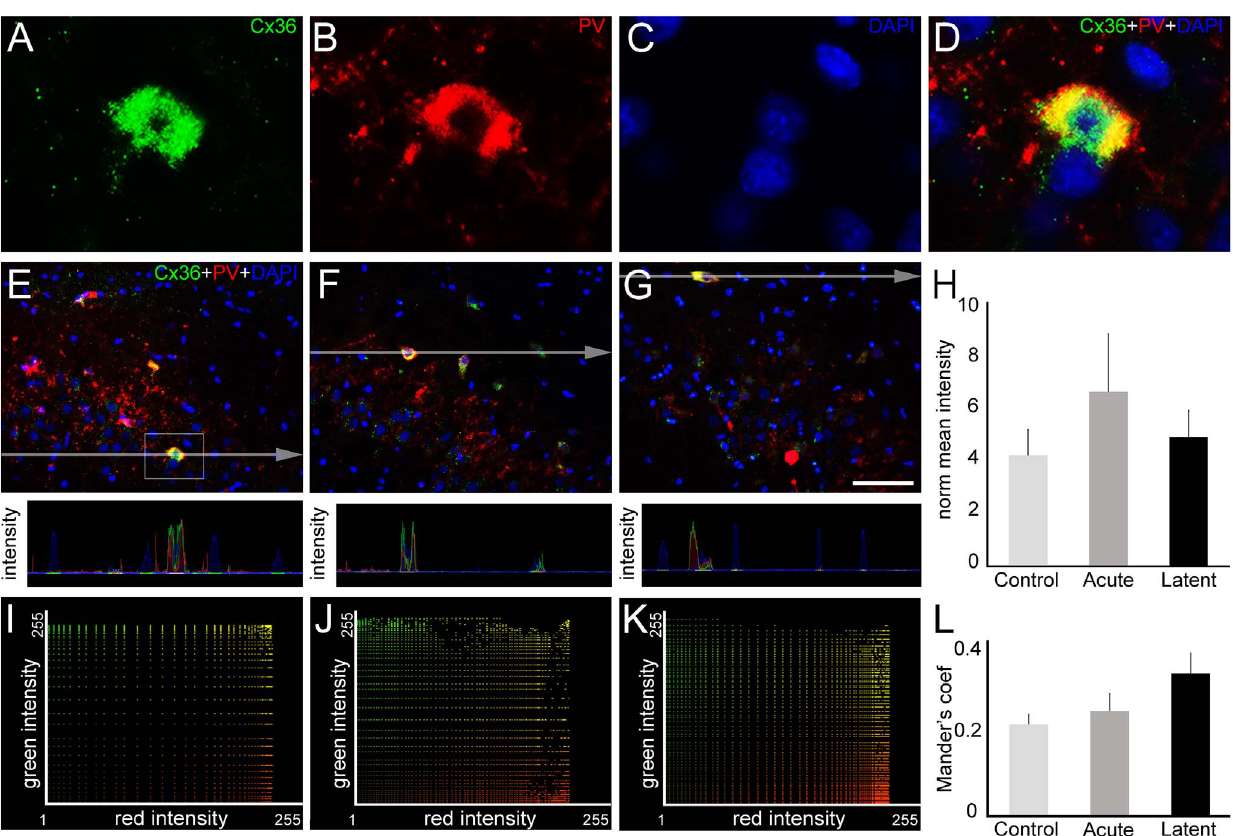
Figure 5. Cx36 expression in parvalbumin (PV)-positive interneurons into CA3. In order to quantify the amount of Cx36 (green) in PV- positive cells (red), we performed double-labeling experiments in coronal sections of rats from control, acute and latent groups counterstained with 4 9 ,6-diamidino-2-phenylindole (DAPI, blue). (A–D) High magnification of the selected area highlighted in the control section (E) shows Cx36 (A), PV (B) and DAPI labeling (C). Colocalization of both proteins is evidenced in (D). (E, F, G) In representative images of CA3 area it is possible to visualize that Cx36 remains in PV-positive cells in acute (F) and latent (G) groups. The pixel intensity profile revealed intersection of the green and red signals, supporting the colocalization of both proteins. (H) Pixel intensity analysis showed no significant differences in Cx36 mean intensity in PV-positive cells between the groups. (I–K) Intensity correlation between green (Cx36) vs. red (PV) channels of representative images from control, acute and latent periods, respectively. (L) Quantitative analysis (n=4 animals per group) revealed that Mander’s colocalization coefficient did not change in acute and latent groups. Bars represent standard errors of mean. Scale bar: 50 m m.